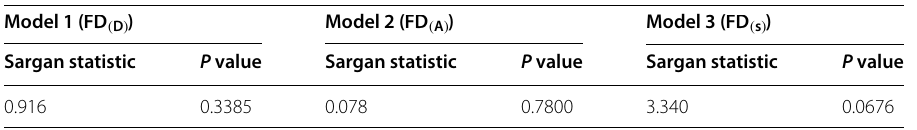
H 0 weak instruments. Outcome rejects H 0 Table 8 Sargan test results